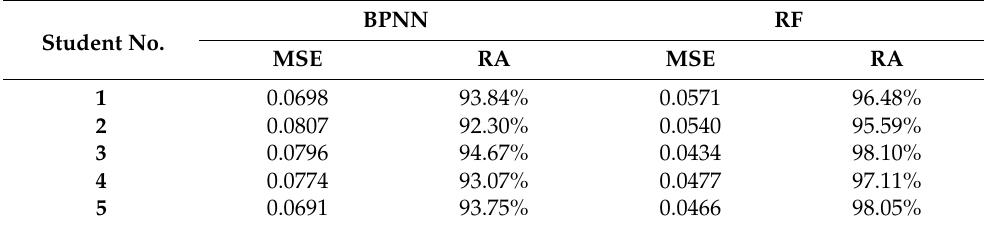
Table 4. Evaluation results of BPNN and RF models in the first experiment. Student No.